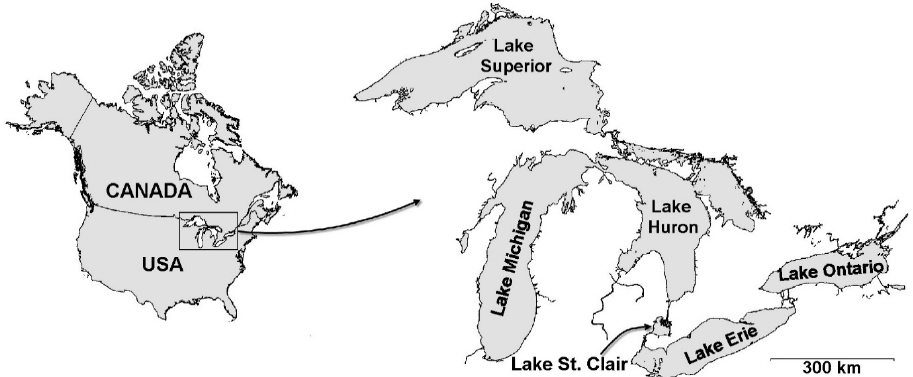
Figure 1. The location of Lake St. Clair.